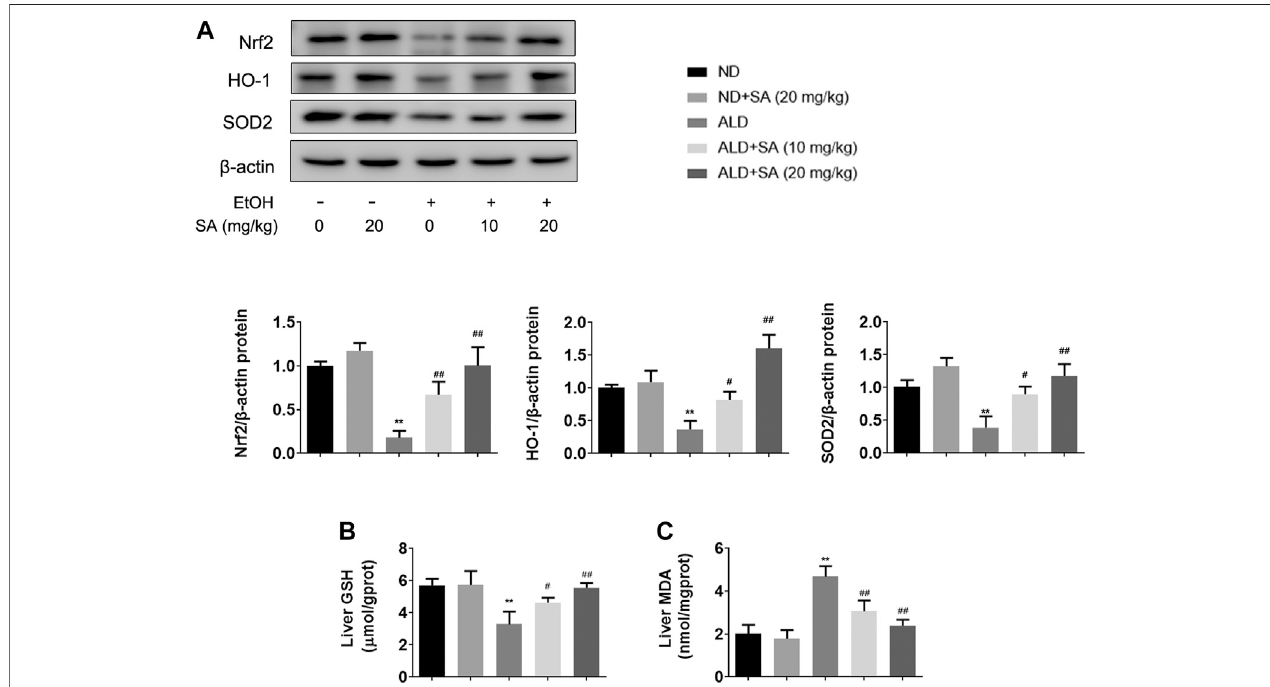
FIGURE 2 | SA reduces alcohol-induced oxidative stress in mice livers. (A) Western blotting of hepatic Nrf2, HO-1 and SOD2 protein levels in livers ( n (cid:2) 3). ** p < 0.01 vs theNDgroup; # p < 0.05, ## p < 0.01 vs theALDgroup. (B) HepaticGSHlevels( n (cid:2) 6). (C) HepaticMDAlevels( n (cid:2) 6).** p < 0.01 vs theNDgroup; # p < 0.05, ## p < 0.01 vs the ALD